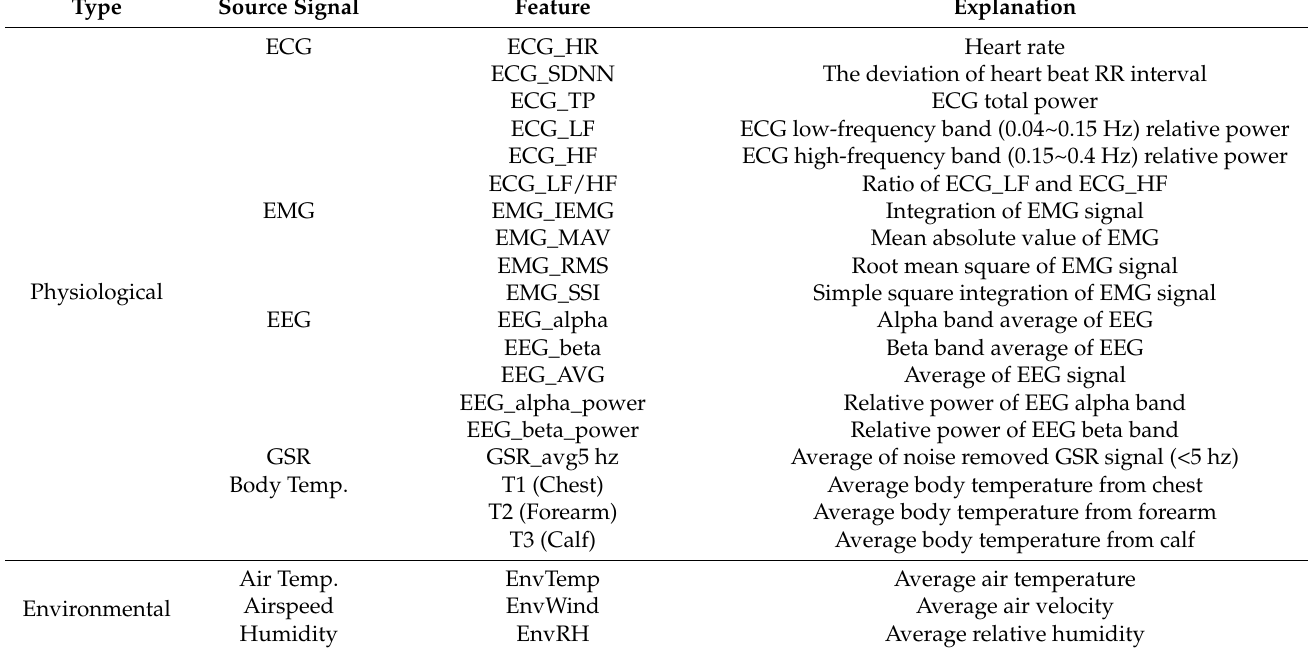
Table 1. Extracted features and